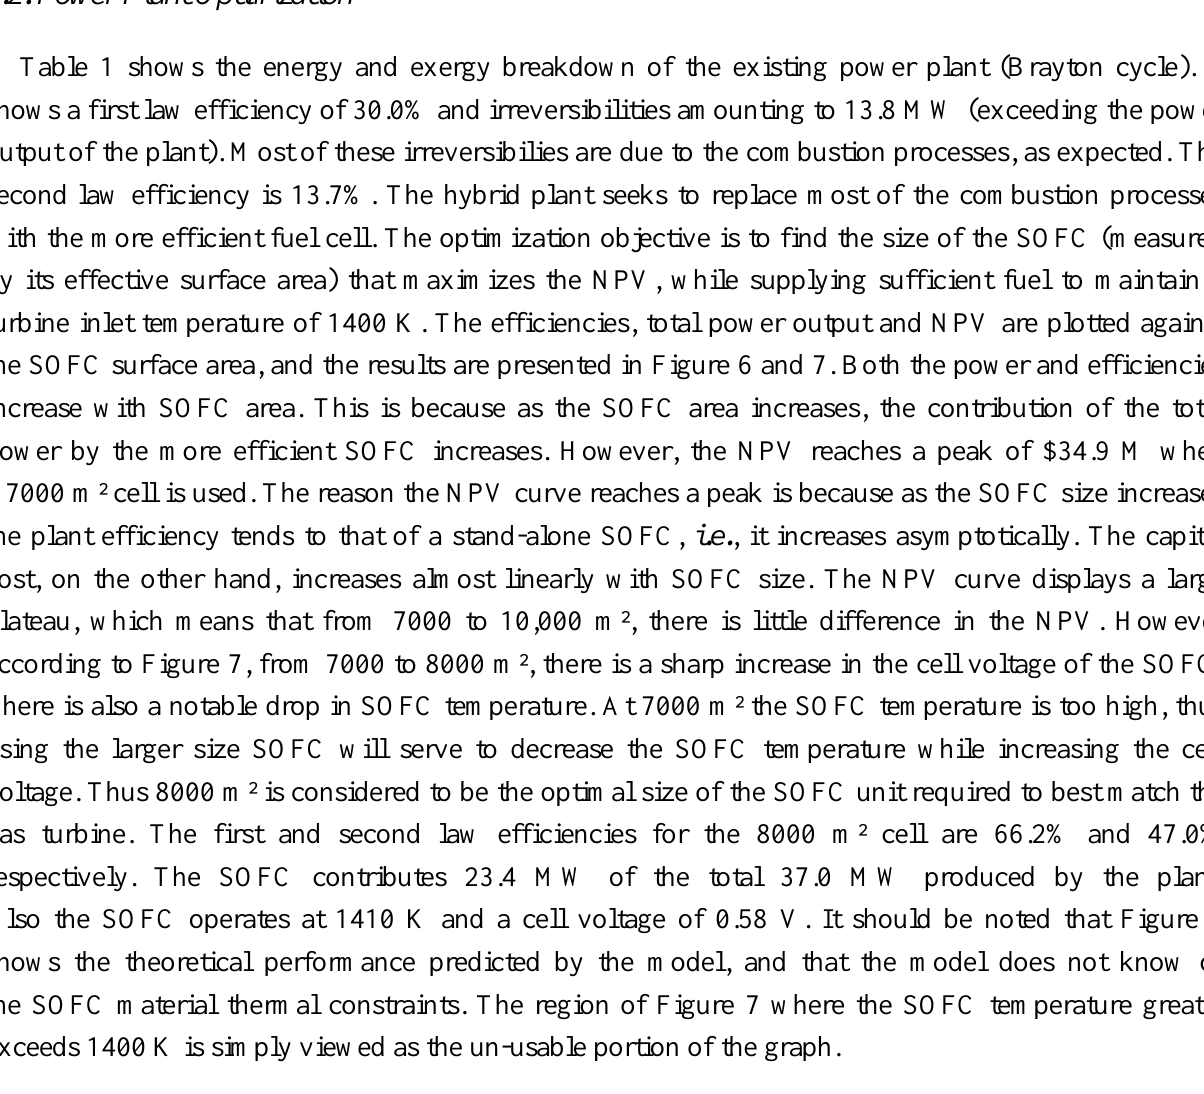
Figure 6. Optimization of the hybrid power